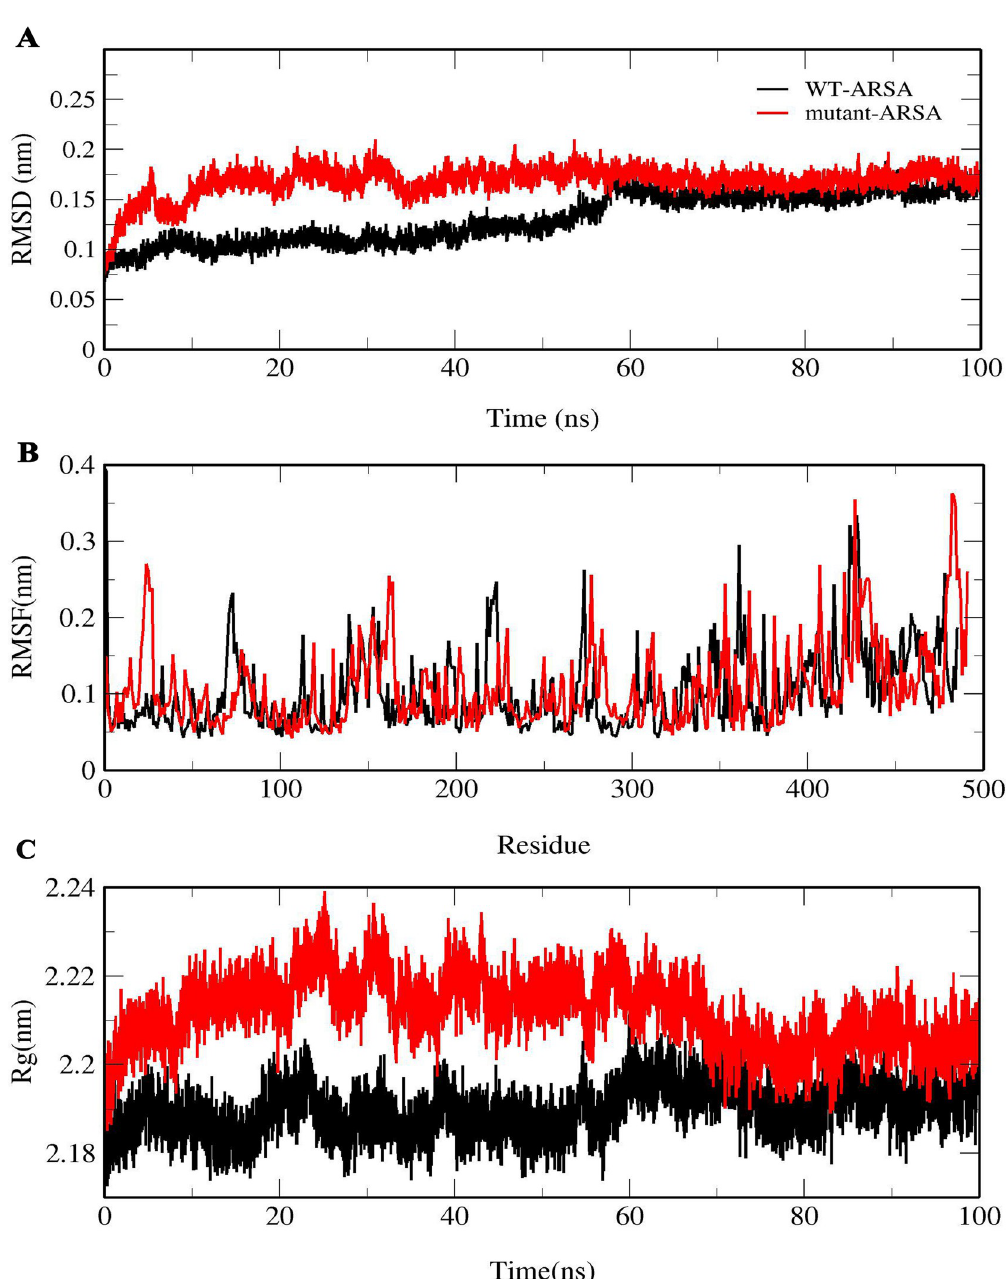
Fig 3. Conformational changes in ARSA proteins. (A) all-atom RMSD, (B) RMSF and (C) Rg of WT-ARSA and mutant- ARSA. provide noticeable data on the diverse conformational states to the ARSAs in the 100 ns-MD simulation (Fig 6B and 6C). It is observed from Fig 6 that the PC1 and PC2 motion modes of the mutant-ARSA occupied larger spaces than those of the WT-ARSA, illustrating the confor- mational rearrangements which lie at the root of the mutation.